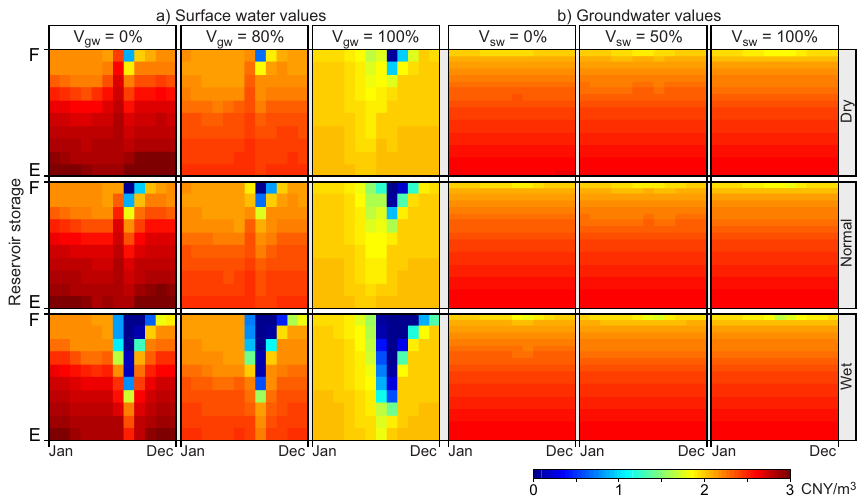
Figure 4. Temporal changes of the water values (CNYm − 3 ) for the climate period before 1980. The marginal water value is the true value of storing a unit volume of water for later use and varies with reservoir storage levels, runoff flow class, and time of the year. (a) Surface water values at fixed [0, 80, 100%] groundwater aquifer storage. (b) Groundwater values at fixed [0, 50, 100%] surface water reservoir storage. The reservoir storage is shown from E (empty) to F (full).